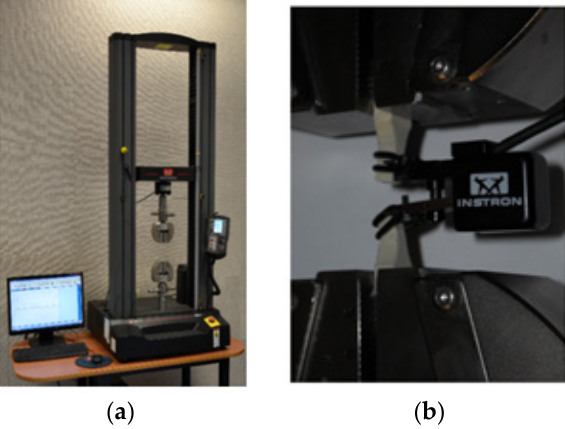
Figure 4. Test stand: ( a ) Instron 5966 testing machine, ( b ) tensile test and specimens in holders.